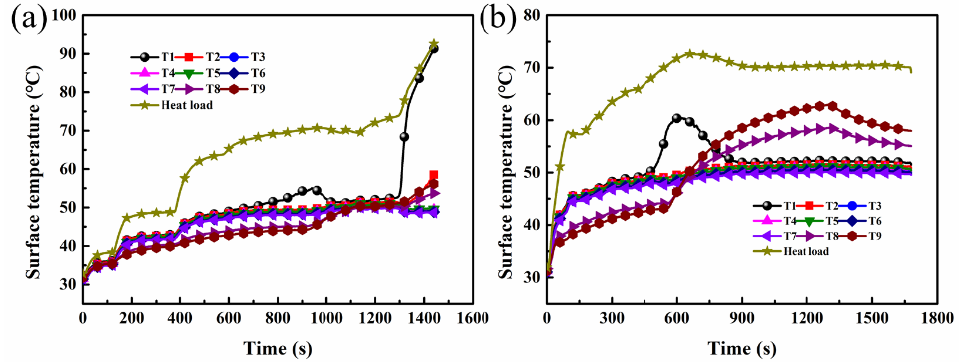
Figure 5. The surface temperature distribution of TSHP − 1 after exceeding the threshold critical power (heat load A was 65 W) with different heat load B, including ( a ) 2 W and ( b ) 4 W.